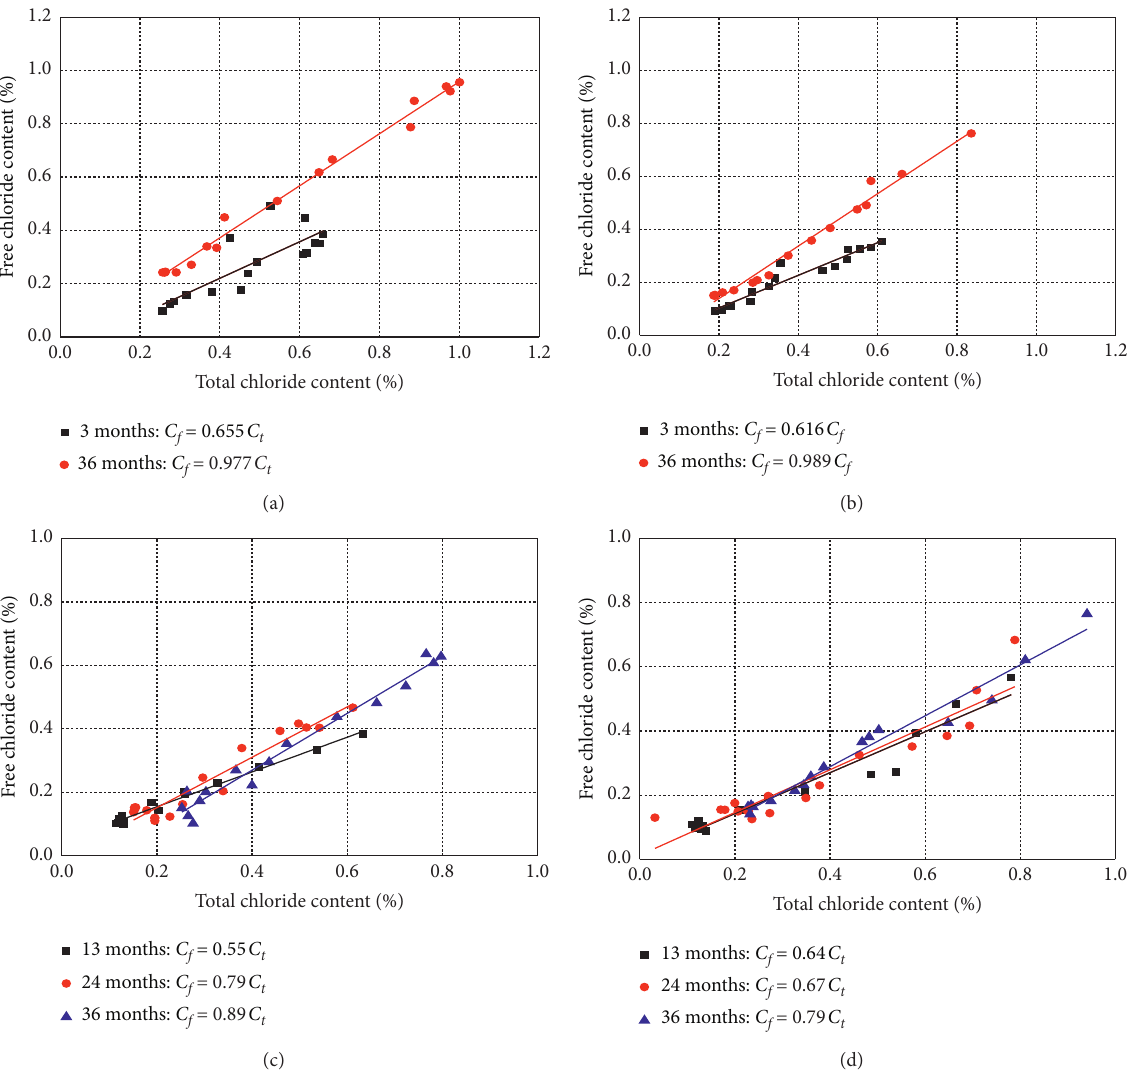
Figure 10: Relationship between total chloride ion content and free chloride ion content. (a) OPC. (b) HPC. (c) Fly ash � 30%. (d) GGBS �